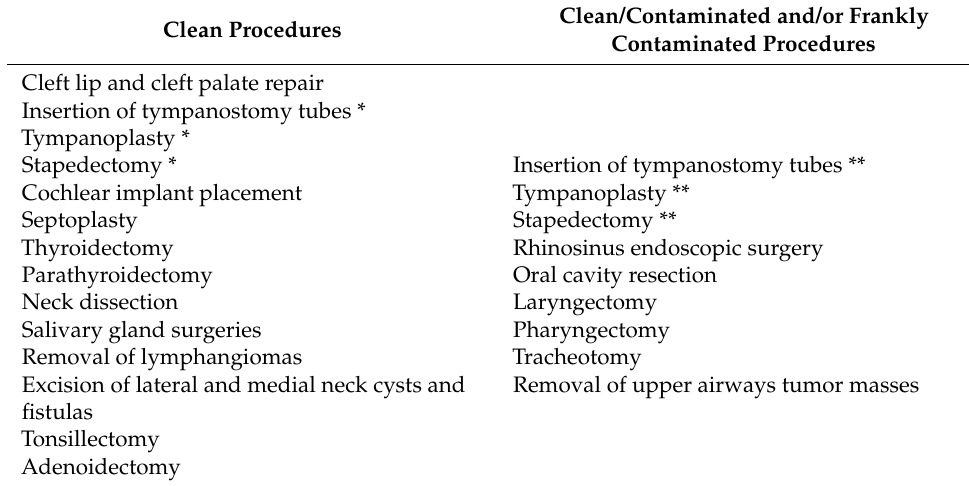
Table 1. Main maxillo-facial and ear-nose-throat (ENT) surgery procedures, divided into clean or clean/contaminated and/or frankly contaminated.